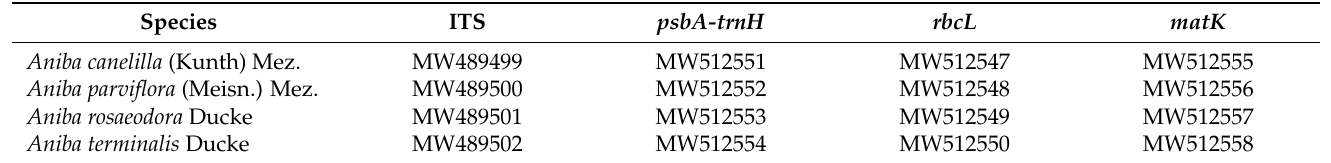
Table 5. GenBank accession numbers of Aniba species collected in the Amazon. Species ITS psbA-trnH